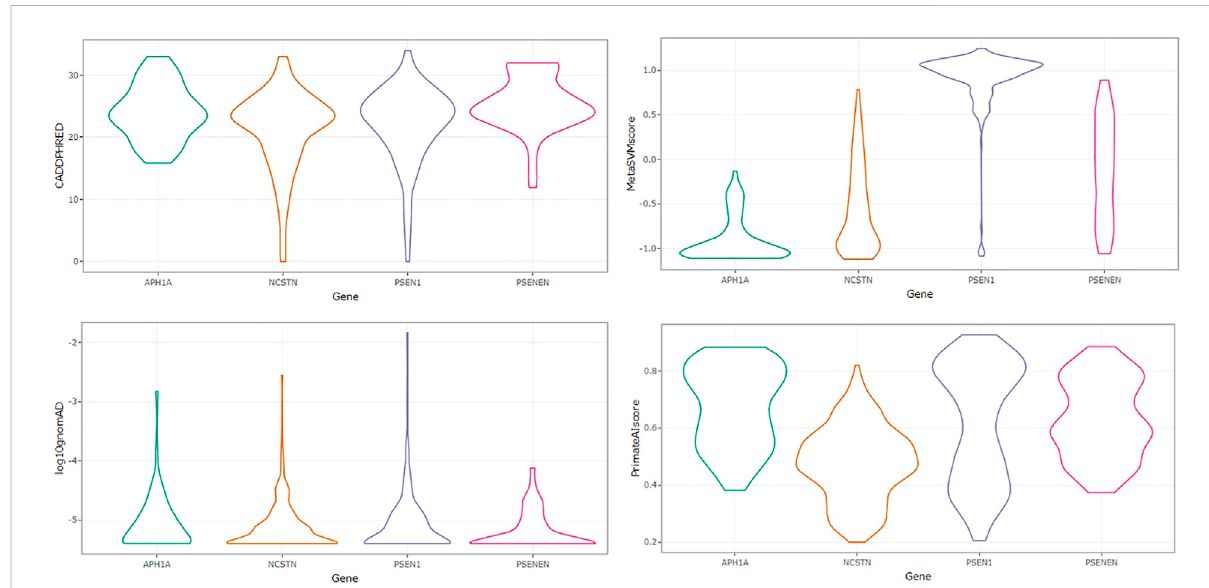
FIGURE 2 Violin plots showing the distribution of PHRED-scaled CADD scores, MetaSVM, variant allele frequencies, and PrimateAI scores across APH1A, NCSTN, PSEN1 and PSENEN.